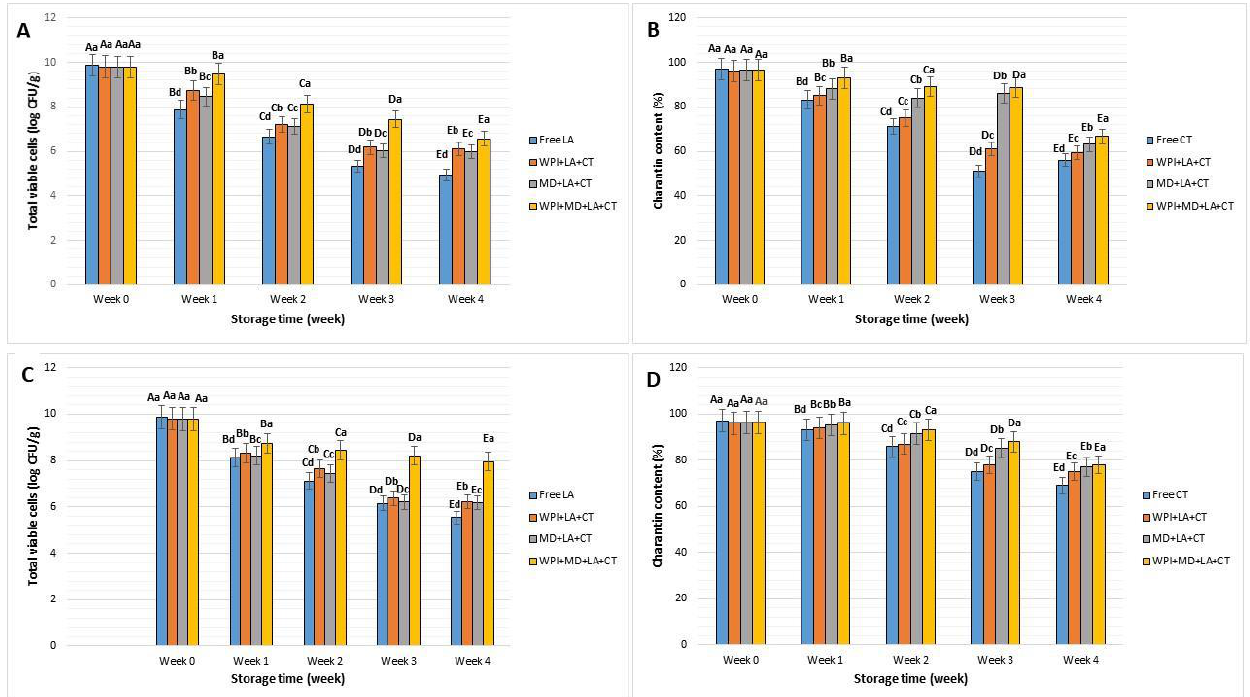
Figure 7. Storage stability at 25 °C for LA ( A ), CT ( B ), and at 4 °C for LA ( C ), CT ( D ). WPI + LA + CT ( A ), MD + LA + CT ( B ), WPI + MD + LA + CT ( C ). WPI + LA + CT: Whey protein isolate + L. acidophilus + Charantin ; MD + LA + CT: Maltodextrin + L. acidophilus + Charantin; WPI + MD + LA + CT: Whey protein isolate + L. acidophilus + Maltodextrin + L. acidophilus + Charantin. Data represent means ± standard deviation. Different uppercase letters above each column represent significant differences for a sample between storage weeks ( p < 0.5), and lowercase letters above each column indicate significant differences between samples within a week. ( p < 0.5).